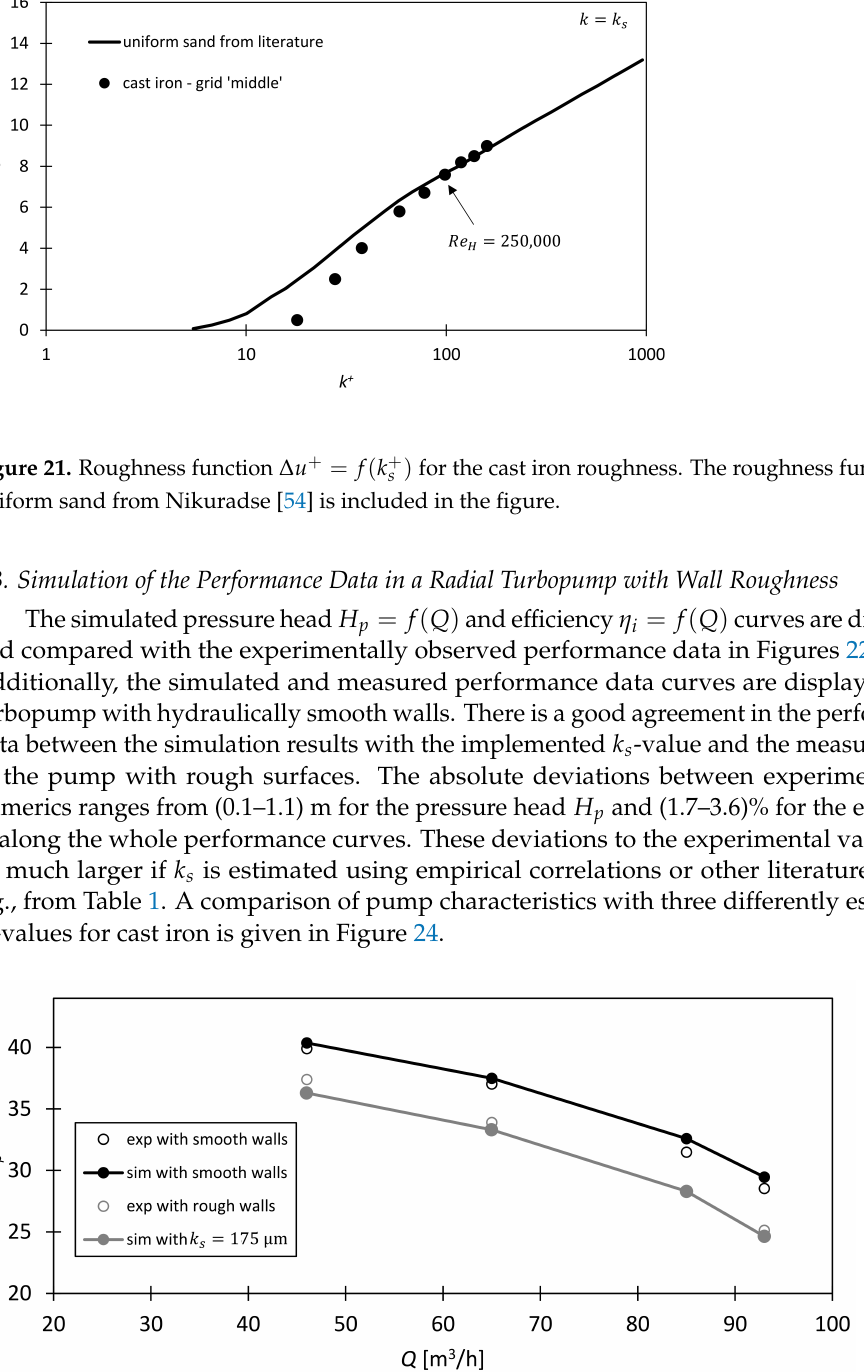
Figure 22. Experimentally and numerically assessed pressure head curve H p = f ( Q ) of the radial turbopump. Please note: The measurement uncertainties of the pump characteristics are not displayed but were less than 1% of the mean